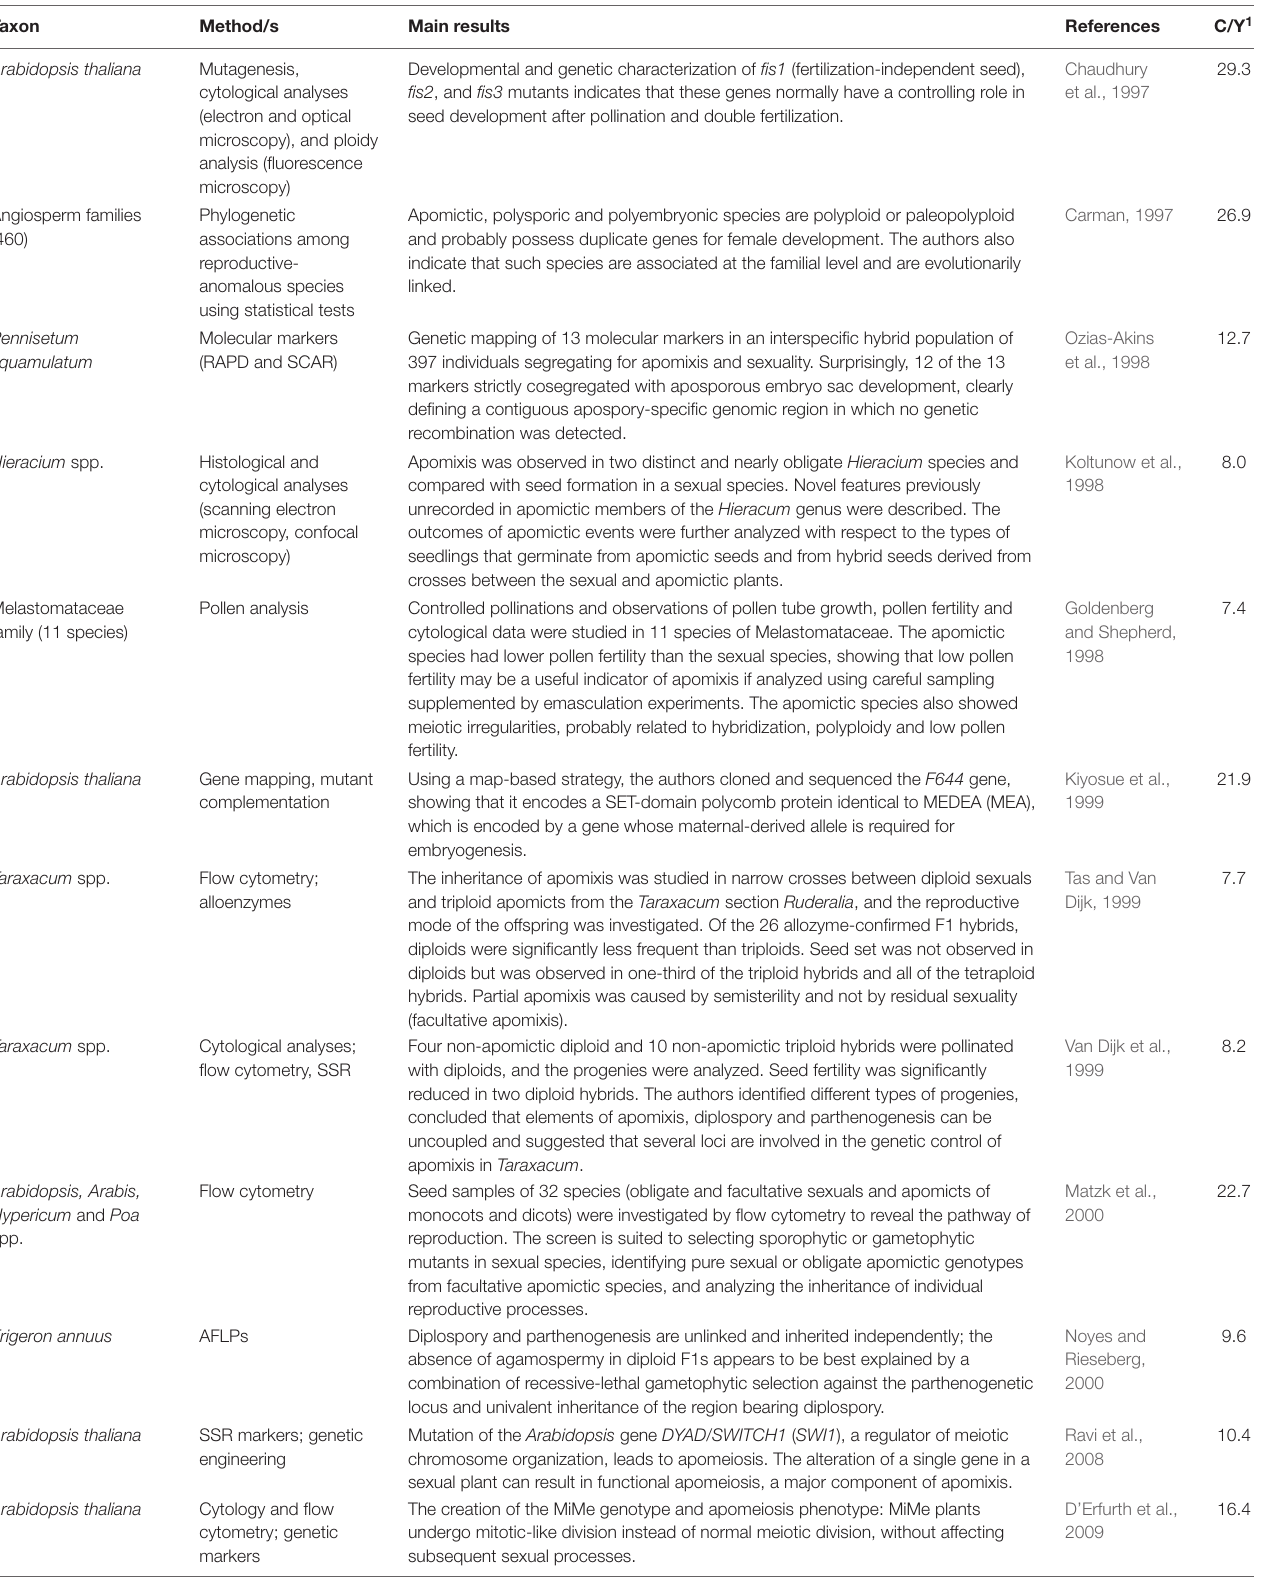
TABLE 1 | List of the 10 most cited publications on apomixis between 1980 and 2000 and between 2001 and